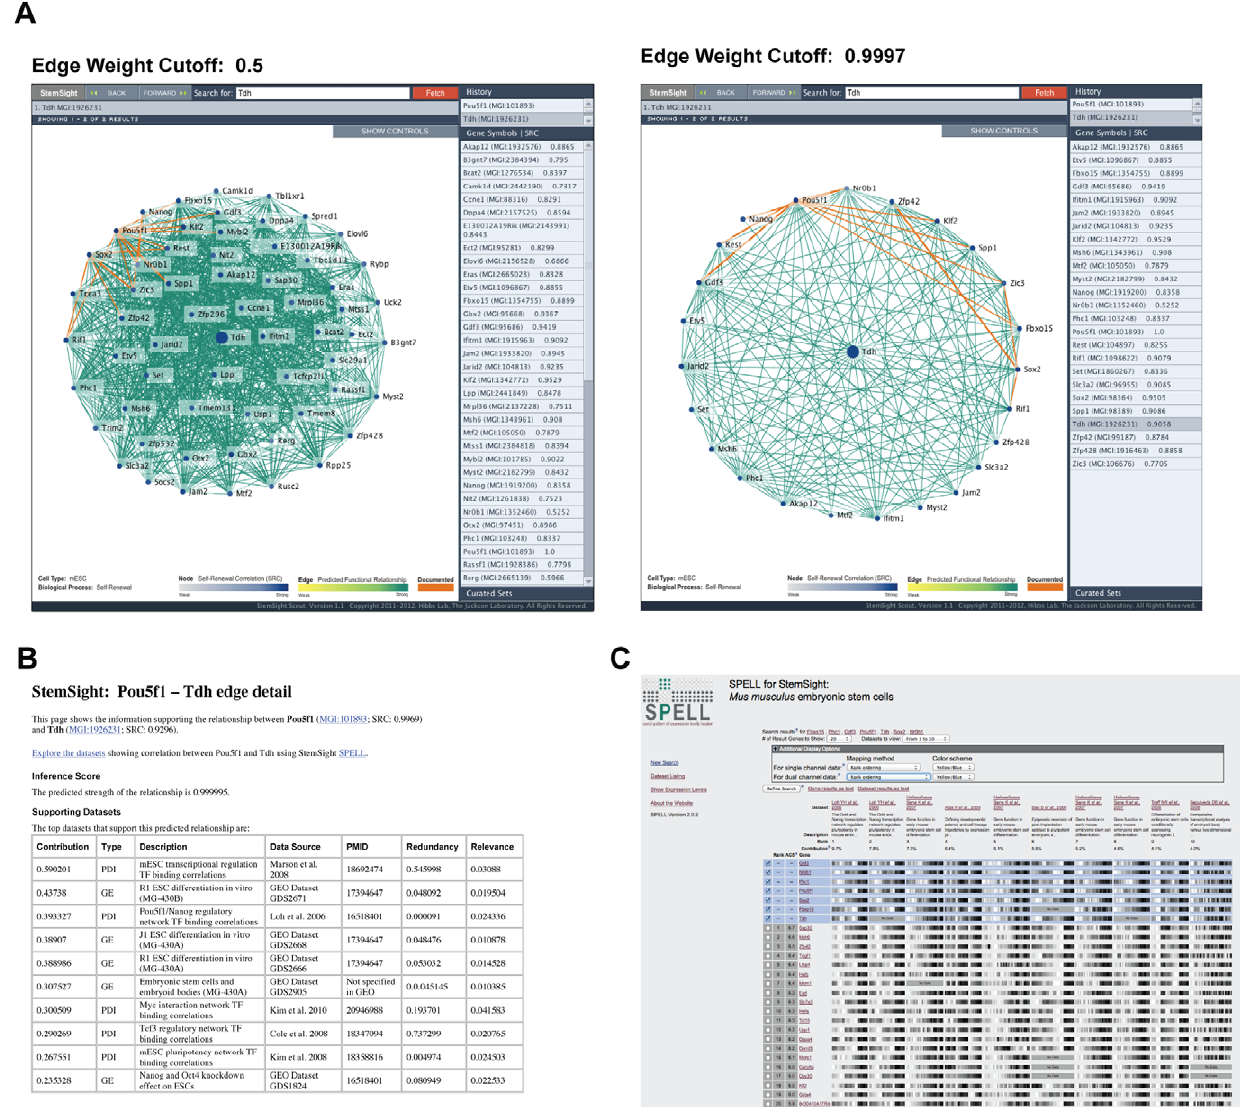
Figure 4. Data Visualization for Mining mESC Self-Renewal Gene Predictions. A. Views of Tdh- centric networks created using our StemSight Scout visualization tool, available at StemSight.org. Adjusting Scout network views to display only edges with inference scores of 0.5 and 0.9997 show that the novel gene Tdh is tightly connected to many well-known self-renewal genes in our training gold standard, including Pou5f1, Sox2, Nanog, Nr0B1, and Phc1. B. Supporting edge info for the Tdh – Pou5f1 edge. Supporting edge information shows that this edge is supported by several protein-DNA interaction (PDI) assays as well as gene expression datasets from a study investigating mESC cell differentiation in different mESC cell lines. For supporting edge detail between Tdh and other gold standard genes, see Figure S5 or explore the Tdh interactome online at StemSight.org/scout. C. SPELL for StemSight Search Results. From a supporting edge information window, you can drill down to the individual gene expression levels in microarray datasets. This view shows how expression data reveals rank-ordered correlations observed between Tdh and gold standard genes Gbf3, Fbxo15, Nr0b1, Phc1, Pou5f1, and Sox2.